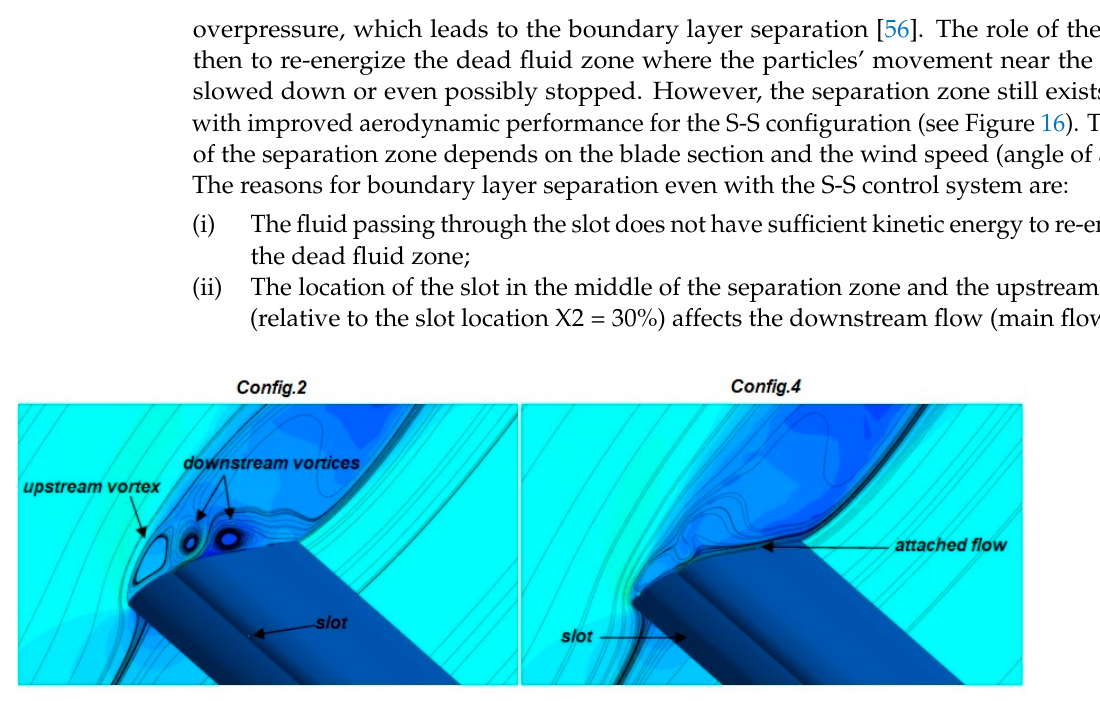
Figure 16. Zoom view on velocity distributions for configurations 2 and 4 at r/R = 0.5 for U ∞ = 19 m s − 1 . Figures 16 and 17 show that the upstream vortex is almost eliminated by adding the first slot at the leading edge. In addition, this leading-edge slot has a positive effect even downstream of the second slot by keeping the boundary layer attached.